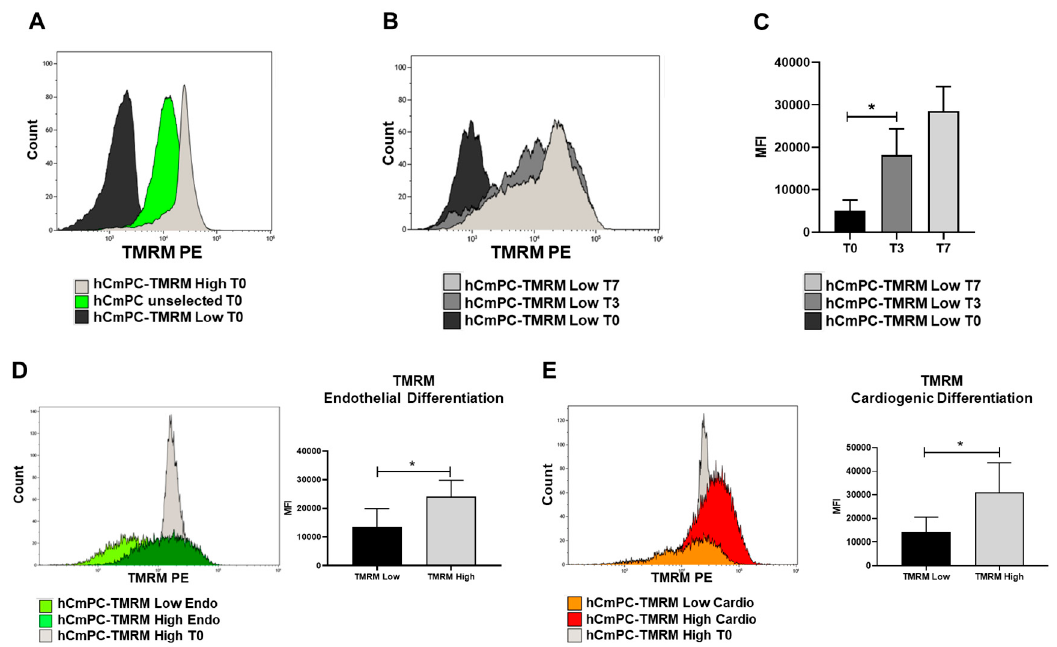
Figure 12. TMRM transition in culture and during differentiation. ( A ) Fluorescence levels of TMRM in the hCmPC population: before sorting (green histogram) and after selection to separate the population with the highest levels of TMRM (high, light grey histogram) from the population expressing the lowest levels of TMRM (low, black histogram). ( B ) Histogram plot of the transition level of TMRM expression in TMRM-low population in a time course experiment from T0 to T7 and its relative quantification ( C ). ( D,E ) Histogram plot and quantification of TMRM expression levels shown as MFI in TMRM-low and high population after endothelial ( D ) and cardiomyogenic ( E ) differentiation. Data are represented as mean ± SD. n = 3 per group. Statistical differences were calculated significant as * p < 0.05, determined by Student’s t-test.